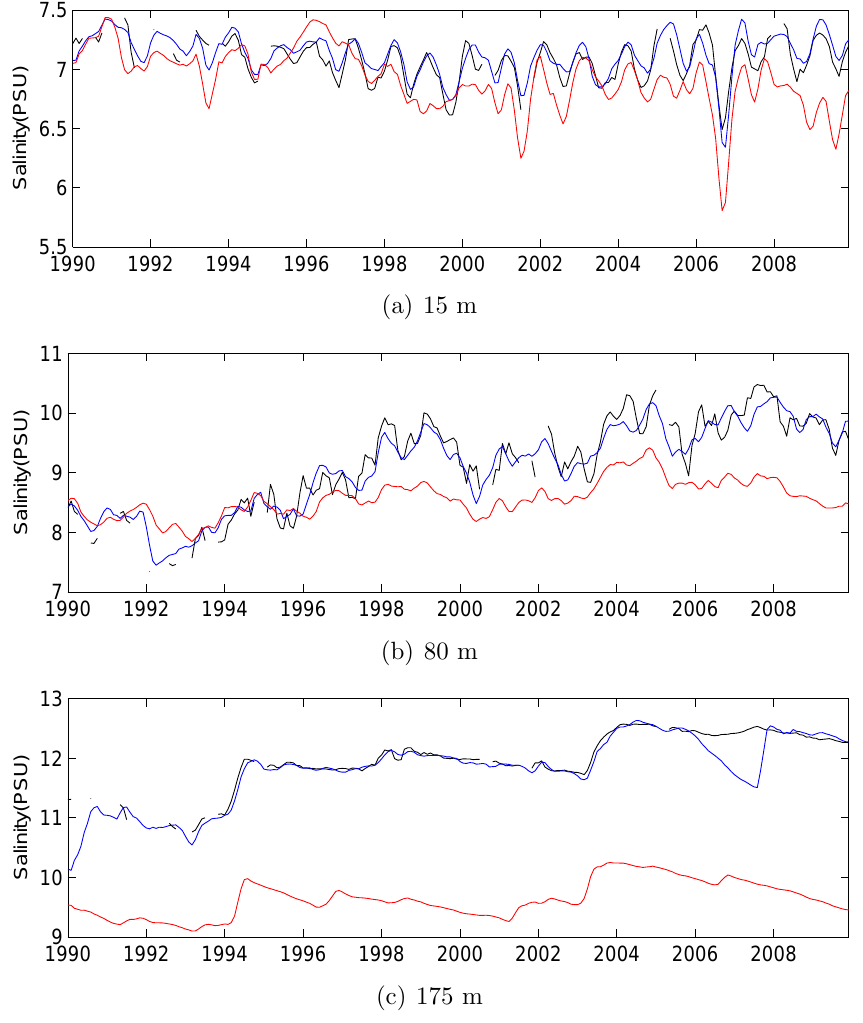
Fig. 8. The time series of salinity at 57.15 ◦ N, 19.92 ◦ E for the depth of (a) 15m, (b) 80m, and (c) 175m. The red is the free run, the blue is Figure 8: The time series of salinity at (57.15 ◦ N, 19.92 ◦ E) for the depth of (a) reanalysis and the black is for 15 m, (b) 80 m and (c) 175 m. The red is the free run, the blue is reanalysis and the black is for observations.